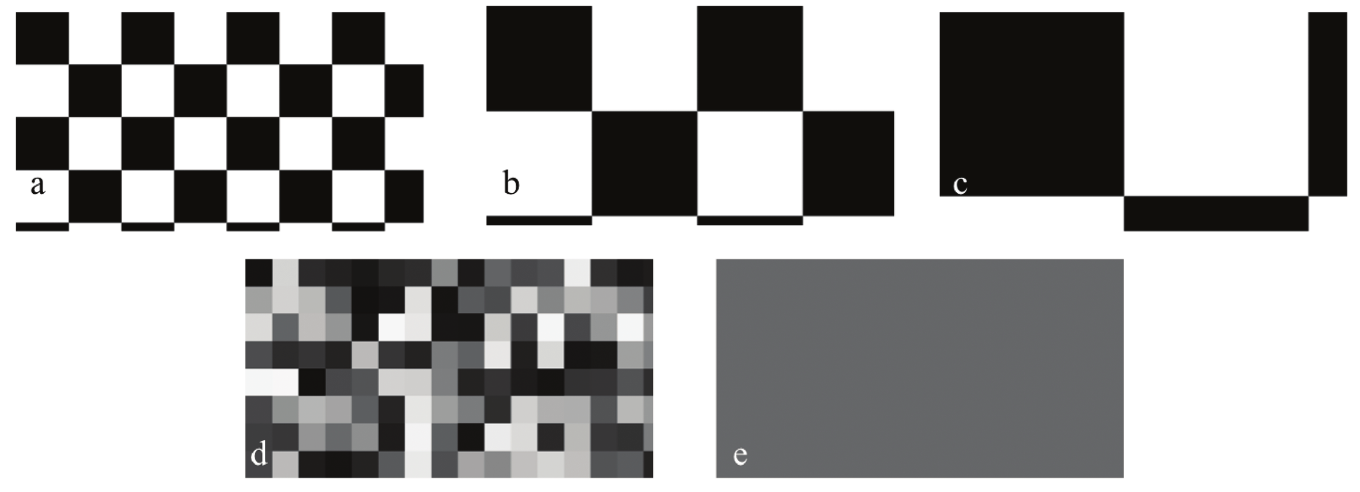
Fig 1. Stimulus patterns used for the tank bottom and side stimuli. (a) Small checkerboard, (b) medium checkerboard, (c) large checkerboard, (d) television static, and (e) uniform grey. In all images, only a portion of the pattern is shown rather than the entire tank wall or tank